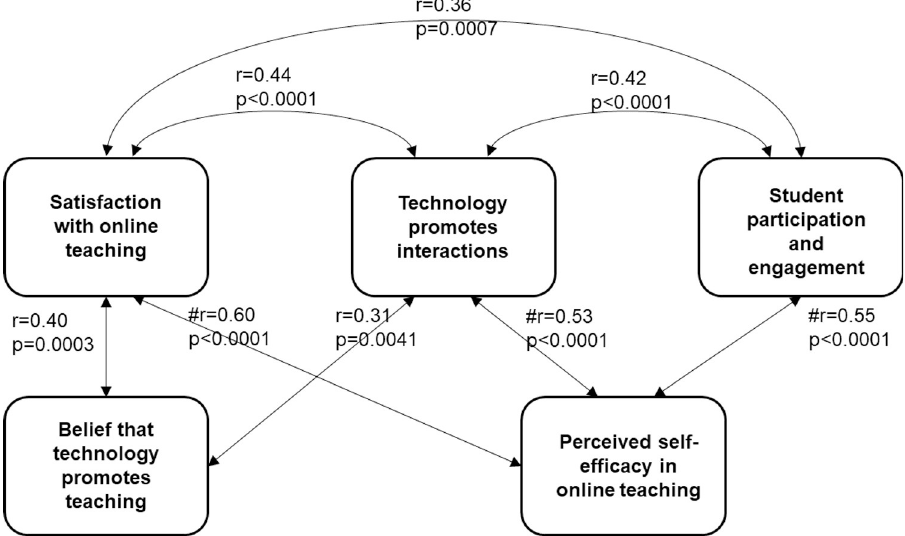
Fig 1. Strong and moderate correlations between the research variables. # High strength of relationship: r value is above 0.5.